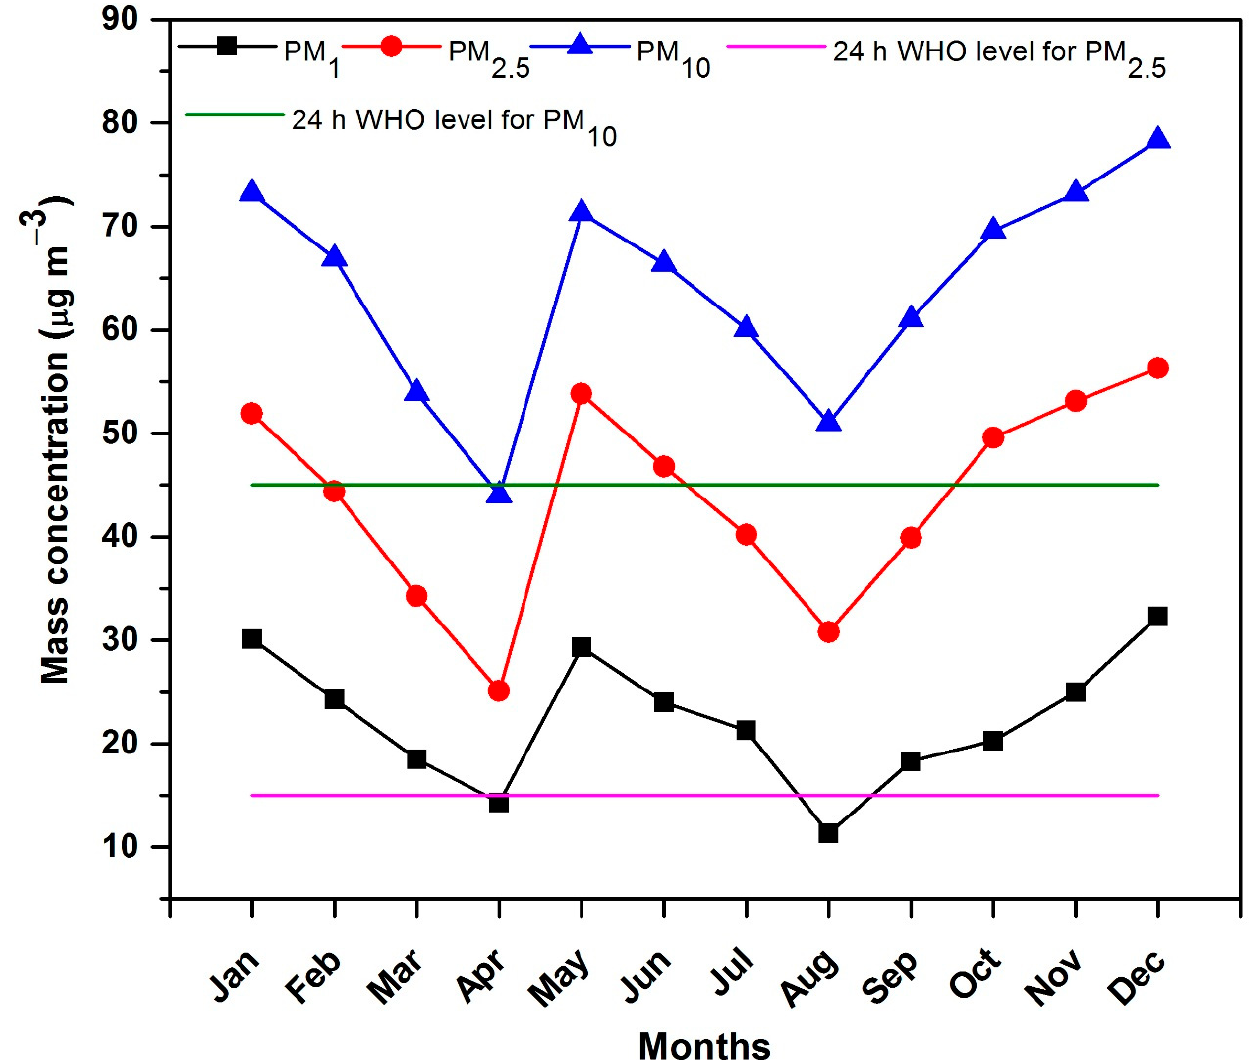
Figure 3. Monthly variation in PM mass concentrations during 2019.